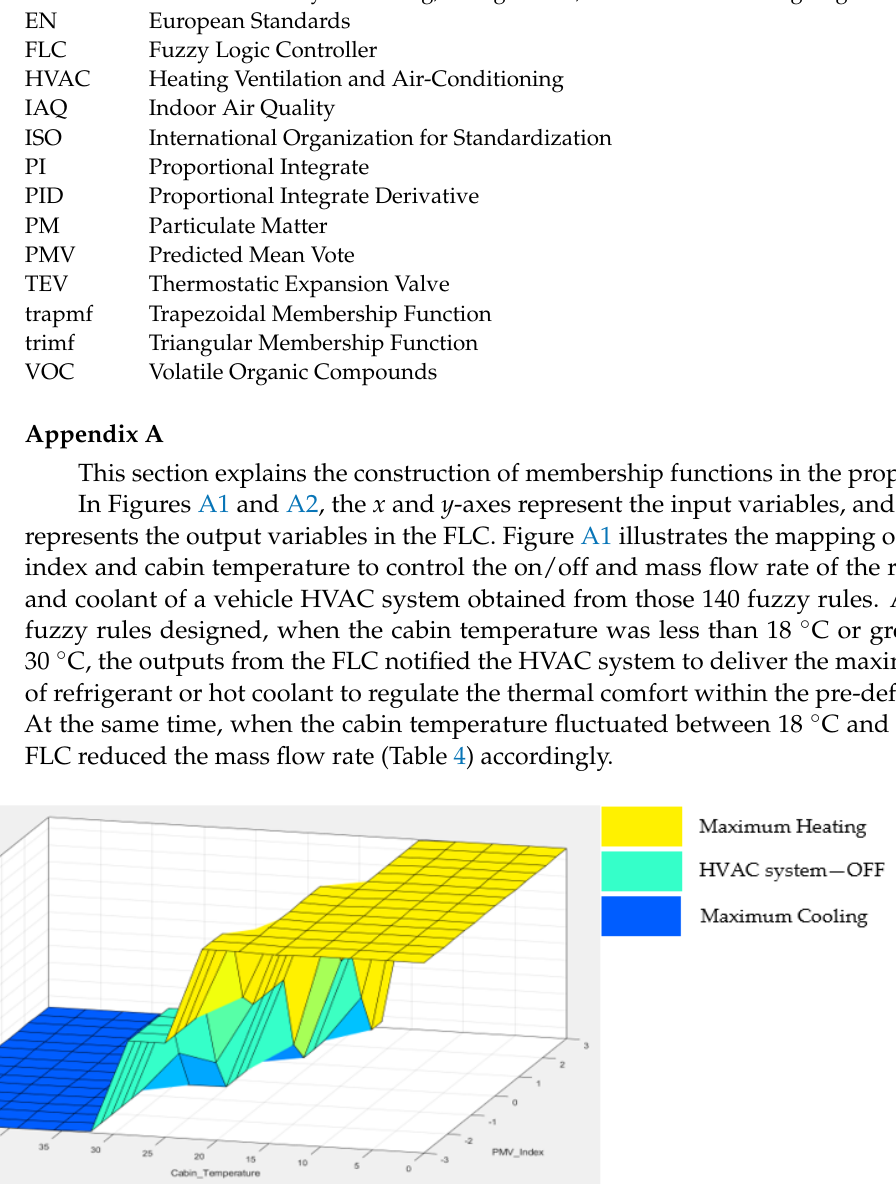
Figure A1. Mapping of the PMV index and cabin temperature membership function to control the HVAC system on/off and mass flow rate.